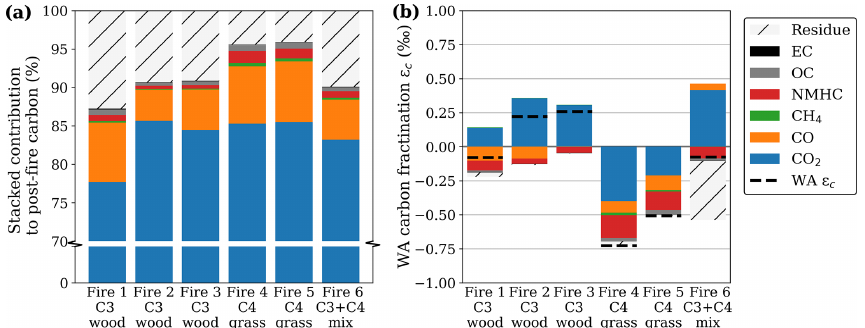
Figure 4. Post-fire partitioning of carbon (a) and the resulting fractionation (b) for oak wood chips (C 3 ) and prairie grass (C 4 ) where the weighted average (WA) was calculated as the fire-averaged measured fractionation weighed by the relative contribution (Fig. 3a on a scale of 0–1) of the respective carbonaceous species to the total post-fire carbon budget. Unlike with the other species, we did not measure the fractionation in NMHC directly but rather estimated it based on